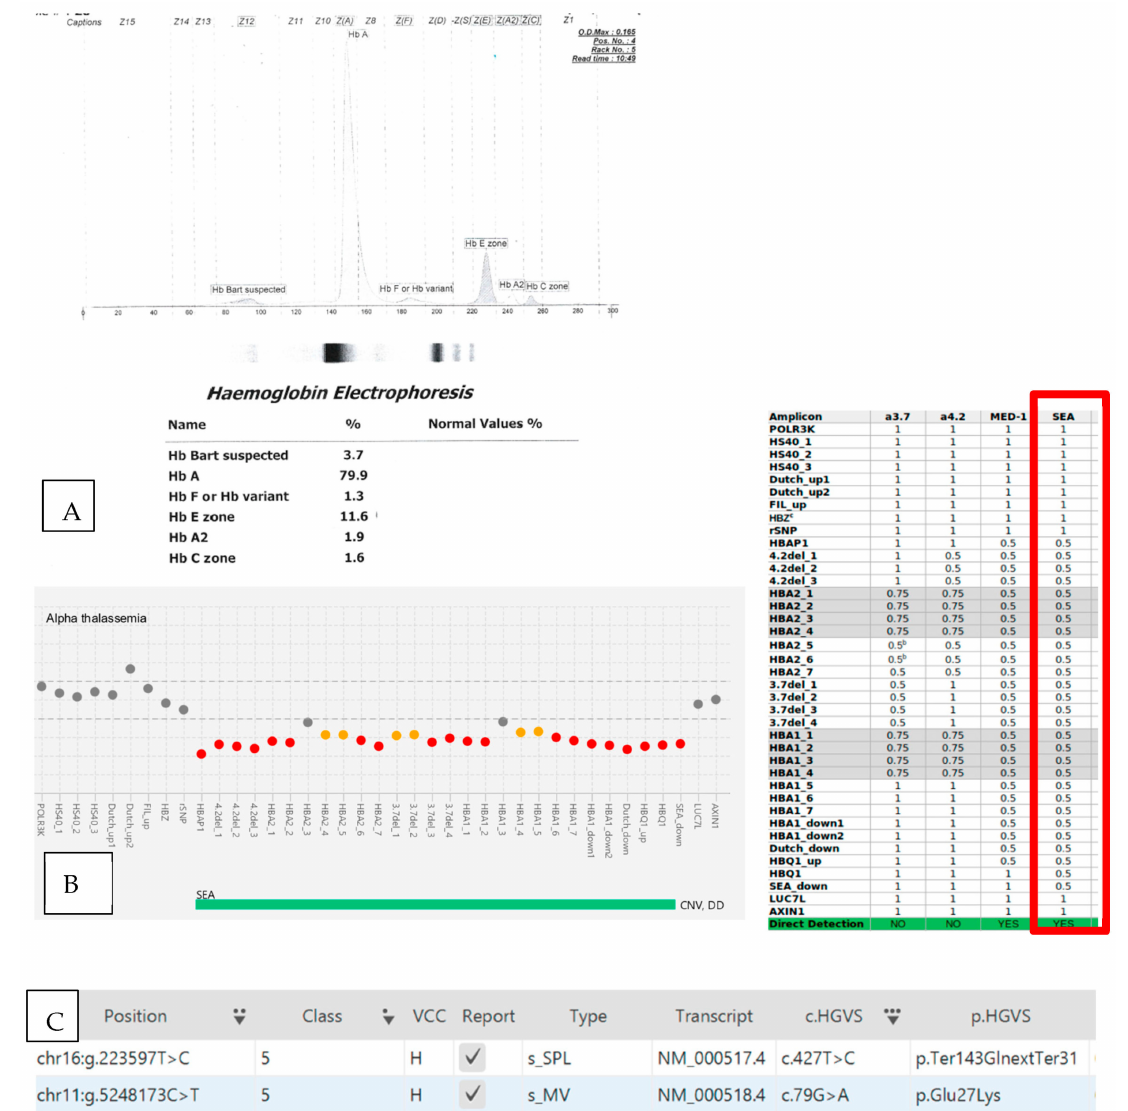
Figure 1. ( A ) Capillary electrophoresis of Case 7, which showed the presence of 1.6% HbCS at Zone 2, 11.6% HbE at Zone 4, and Hb Bart’s (3.7%) at Zone 12. ( B , C ) explains that αα /–SEA for alpha-thalassemia and CD 26 (HBB:c.79G>A) and CD 142 (HBA2:c.427T>C) for beta thalassemia were identified simultaneously from the DEVYSER Software. The table on the right side is the expected coverage in CNV analysis for amplicons in the HBA gene complex. (1 indicates no CNV , while 0.5 indicates deletion, and 0 indicate absence of coverage) (Red dot indicates CNV less than or equal to 0.60 or greater than or equal to 1.66, while orange dot indicates, CNV between 0.60 and 0.7 and between 1.50 and 1.66 respectively) ( b These amplicons may not be affected by the several types of 3.7-deletion and triplication, leading to an absence of CNV, c “HBZ” Amplicons may demonstrate benign deletions or duplications or